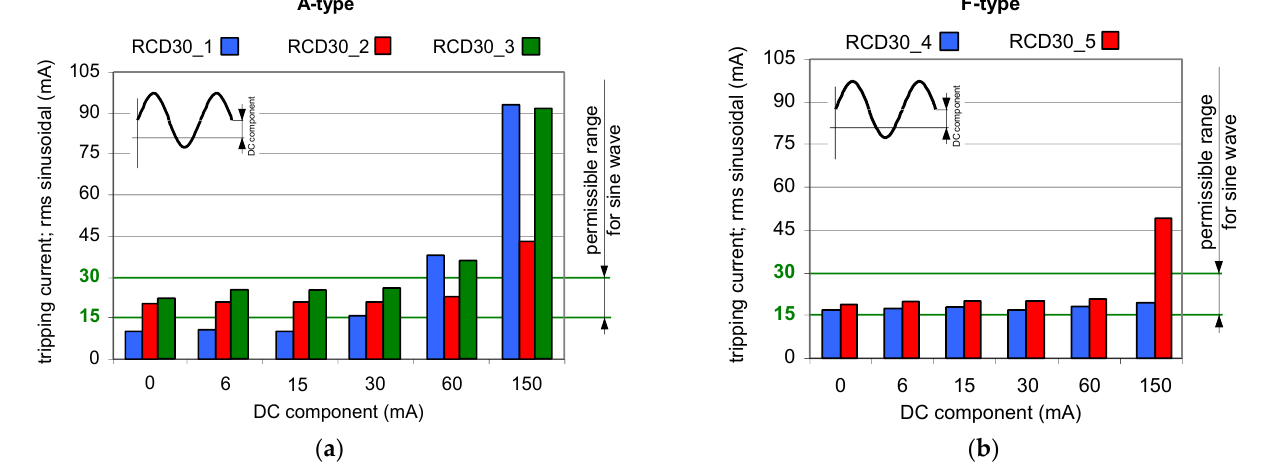
Figure 6. Tripping current (rms value of the AC sinusoidal component) of 30 mA RCDs under AC sinusoidal current superimposed by smooth DC component of values 6, 15, 30, 60, and 150 mA: ( a ) A-type RCDs (three tested RCDs); ( b ) F-type RCDs (two tested RCDs).